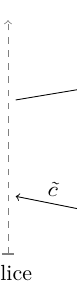
Figure 6: An IND-2CCA attack against a bidirectional channel Ch ∗ obtained from an IND-1CCA secure unidirectional channel Ch via the canonic composition. In the figure time evolves bottom-up (dashed